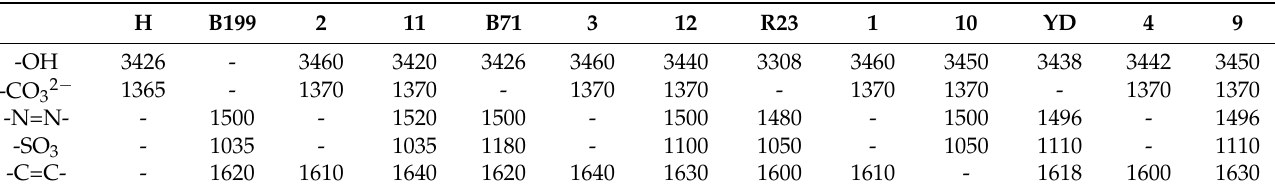
Table 5. A summary of the IR peak